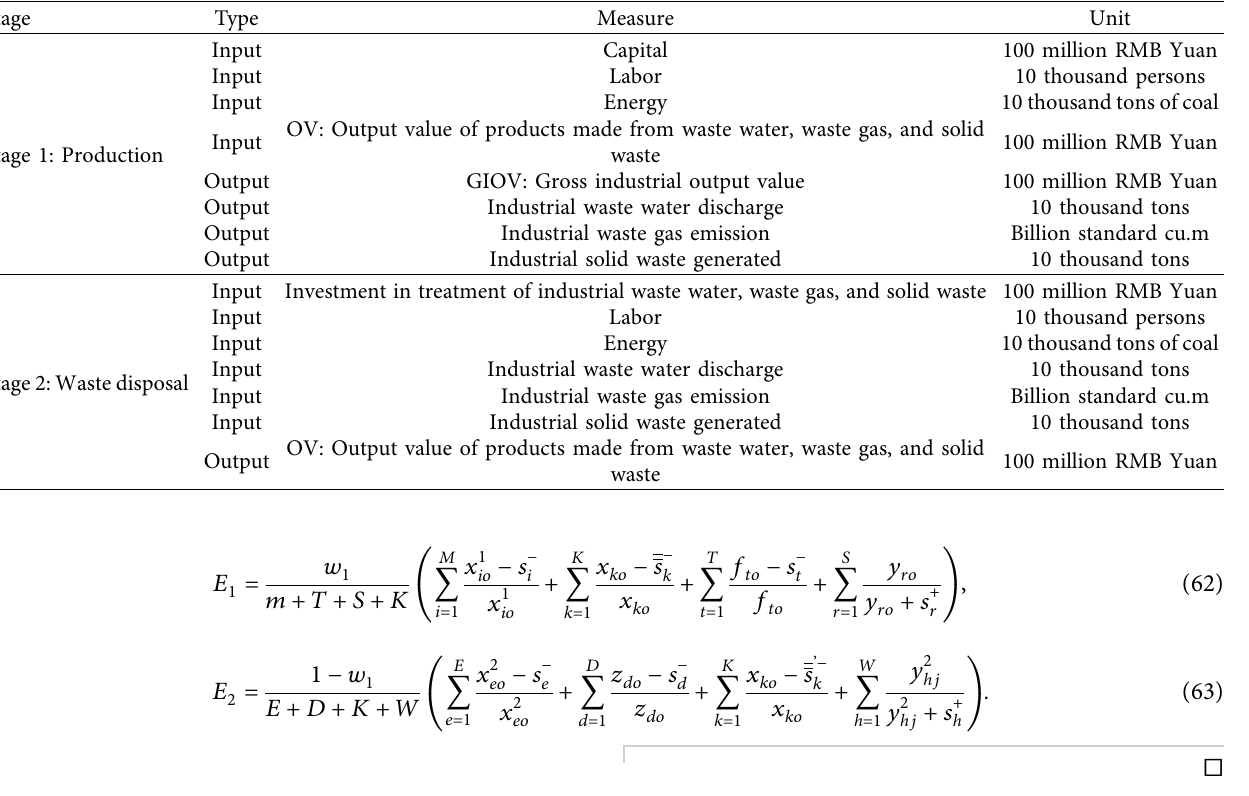
Table 2: Description of inputs and